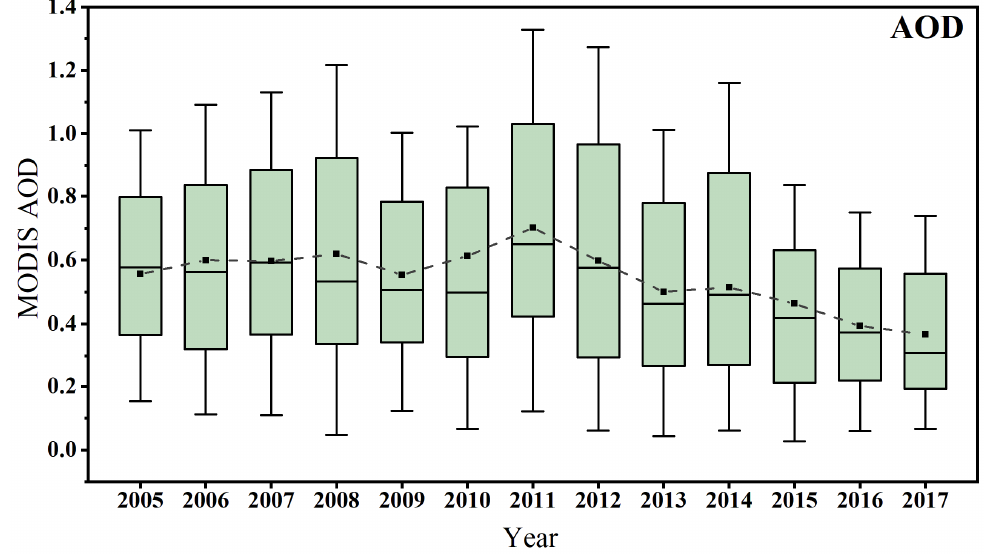
Figure 10. Box plots of annual MODIS AOD at 550 nm over Hubei province during 2005–2017.